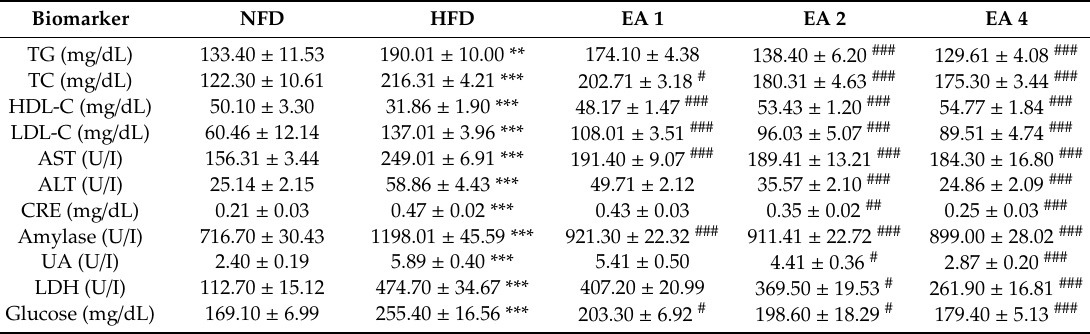
Table 4. E ff ect of ellagic acid on blood biochemical parameters in HFD-fed